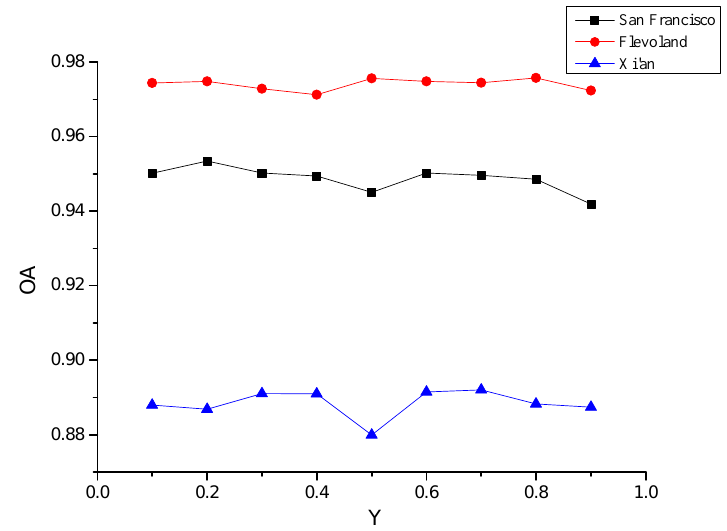
Figure 12. Influence of different γ in L 1 loss.